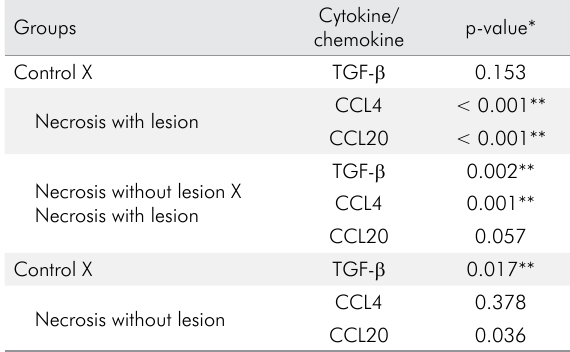
Table 2. Statistical comparison of cytokine and chemokine levels among